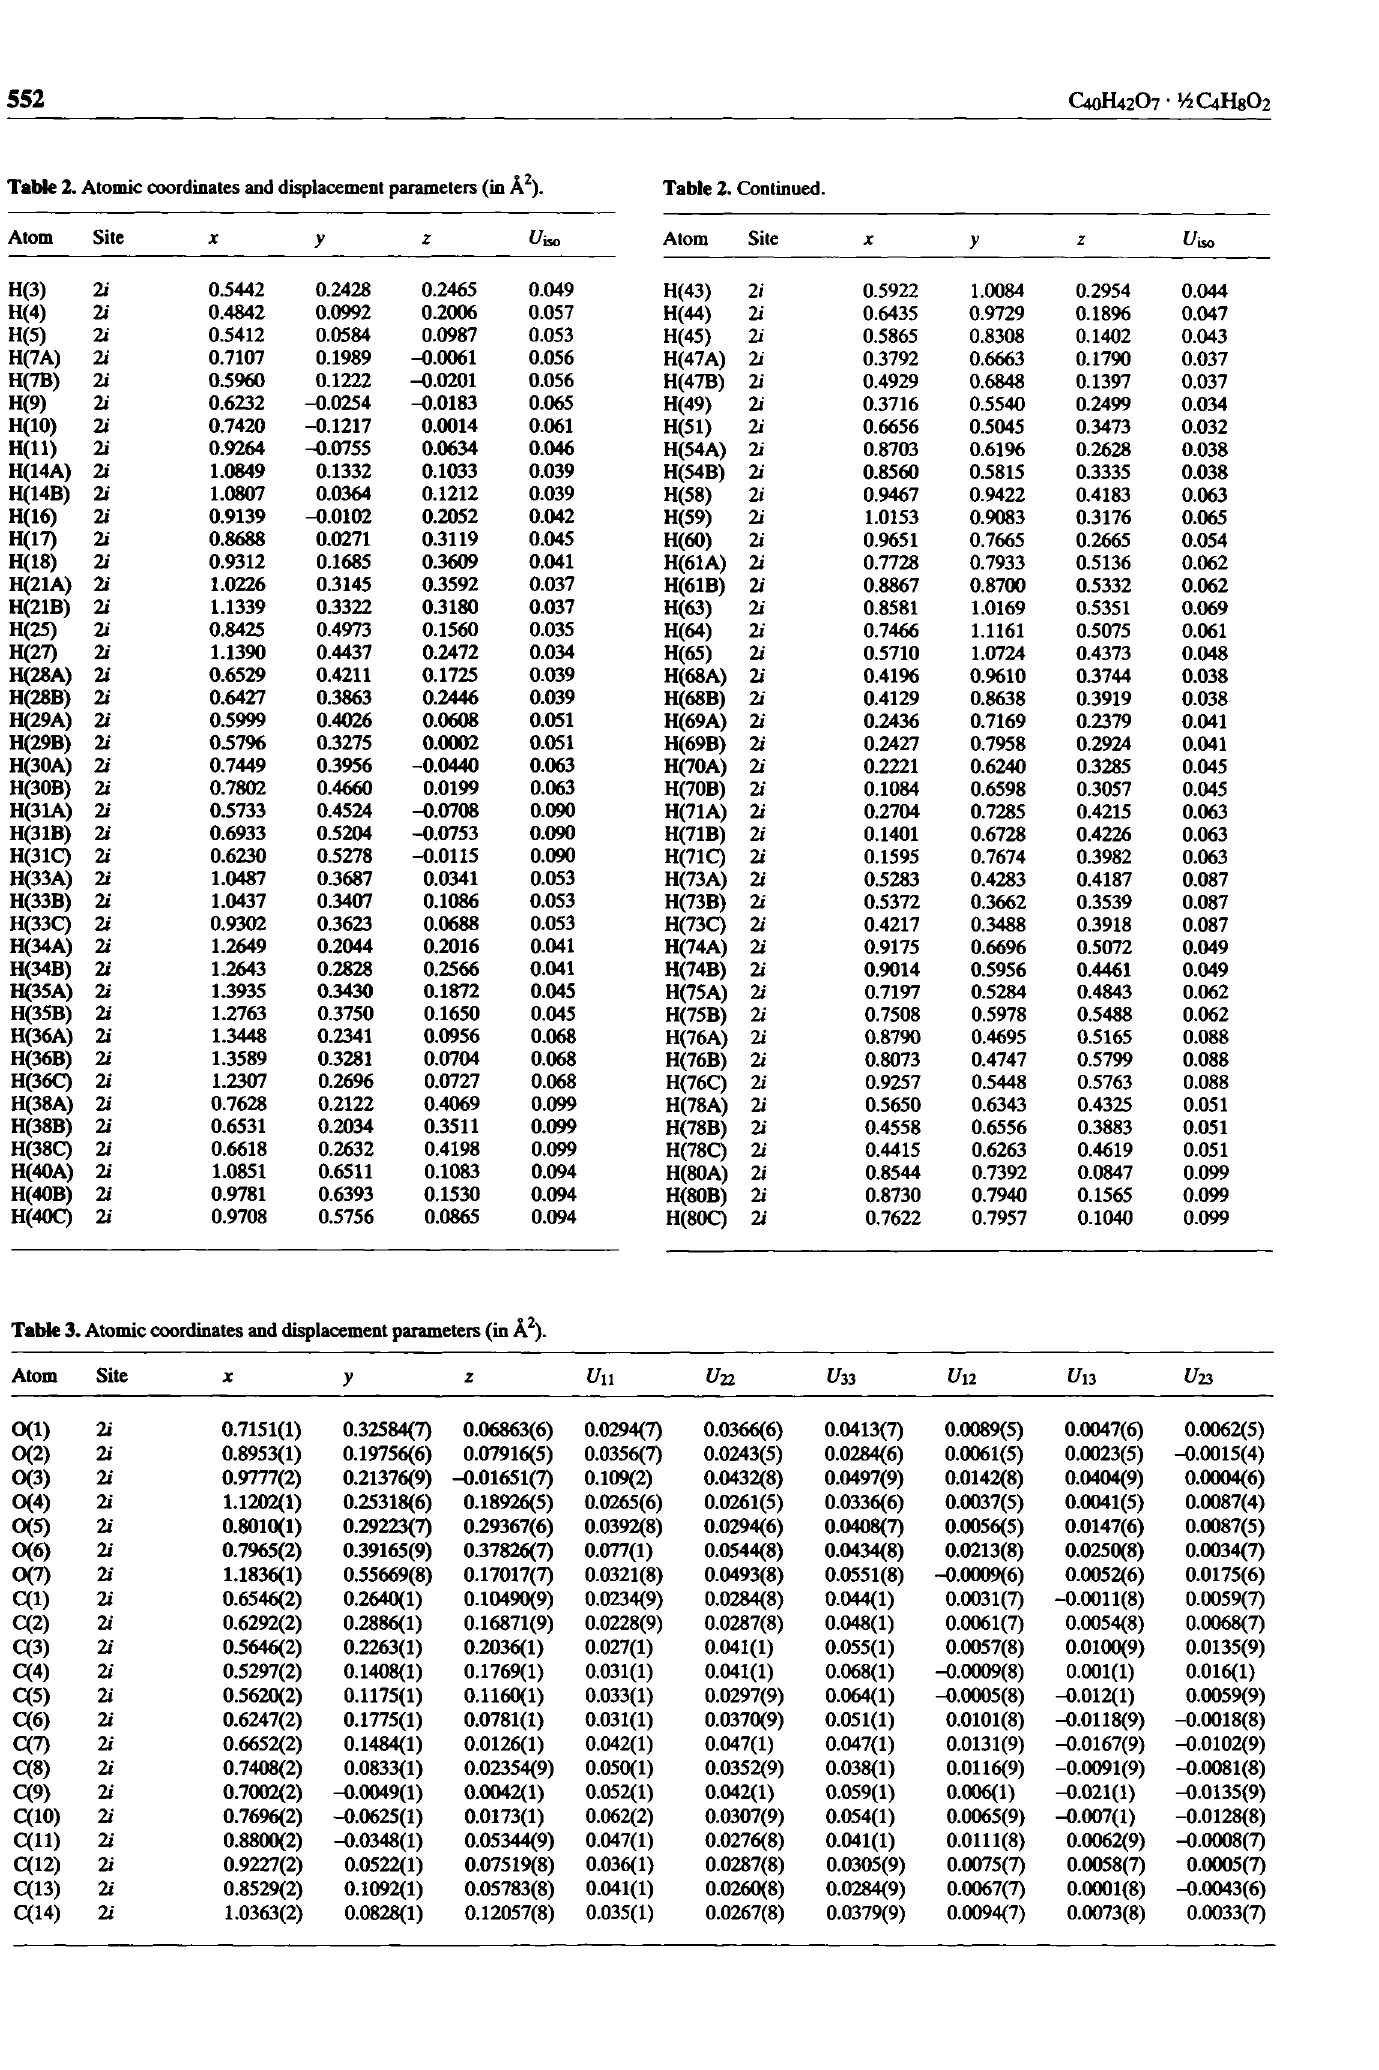
Tabk 2. Atomic coordinates and displacement parameters (in Ä 2 ).